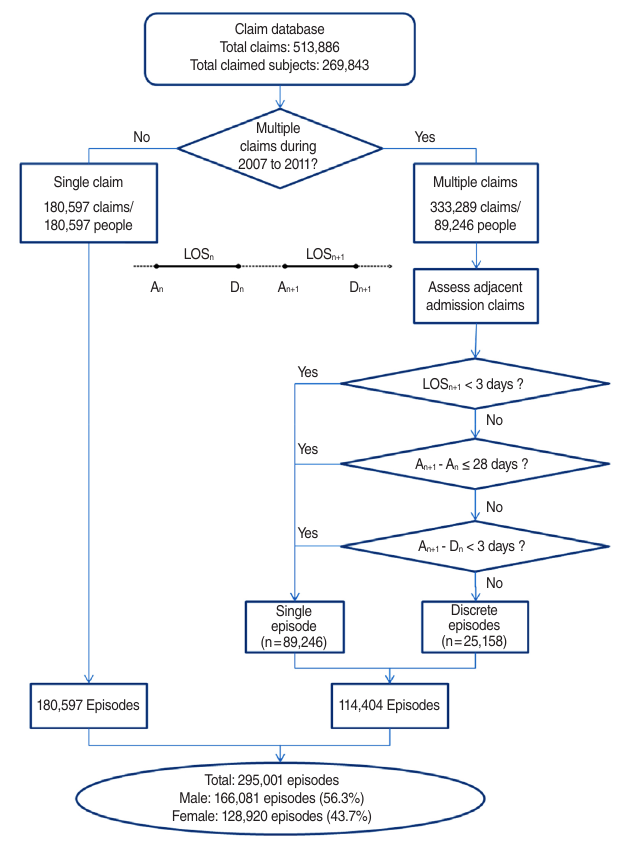
Figure 1. Algorithm for identifying admission episodes of acute myo­ cardial infarction based on claims for acute myocardial